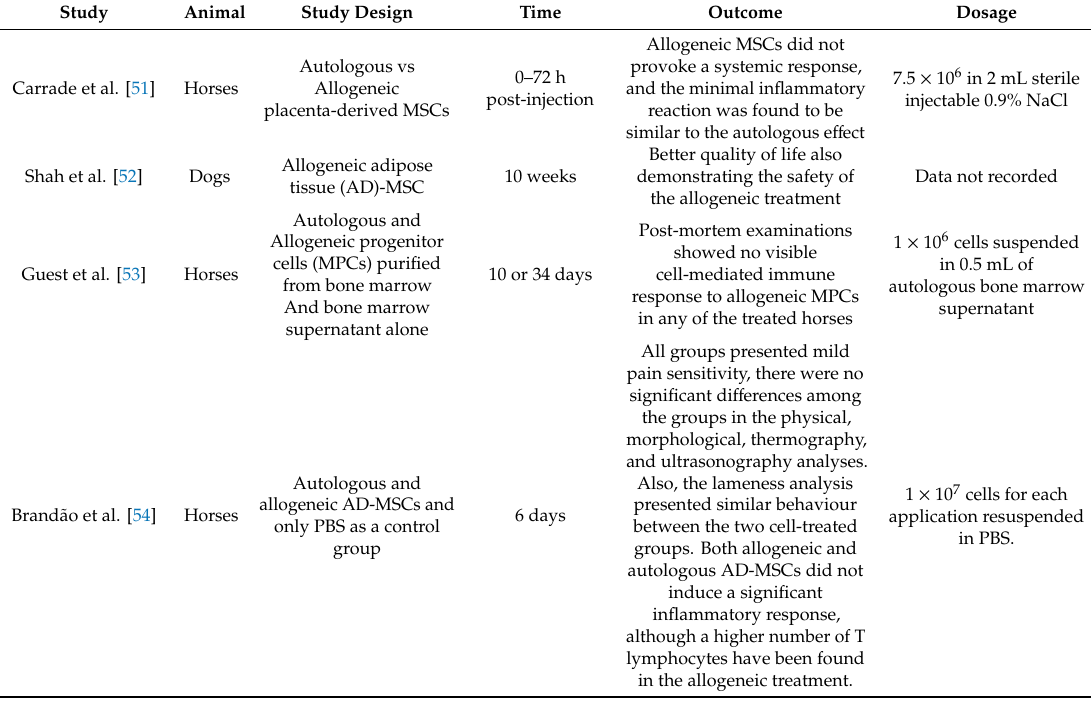
Table 1. Summary of autologous vs allogeneic